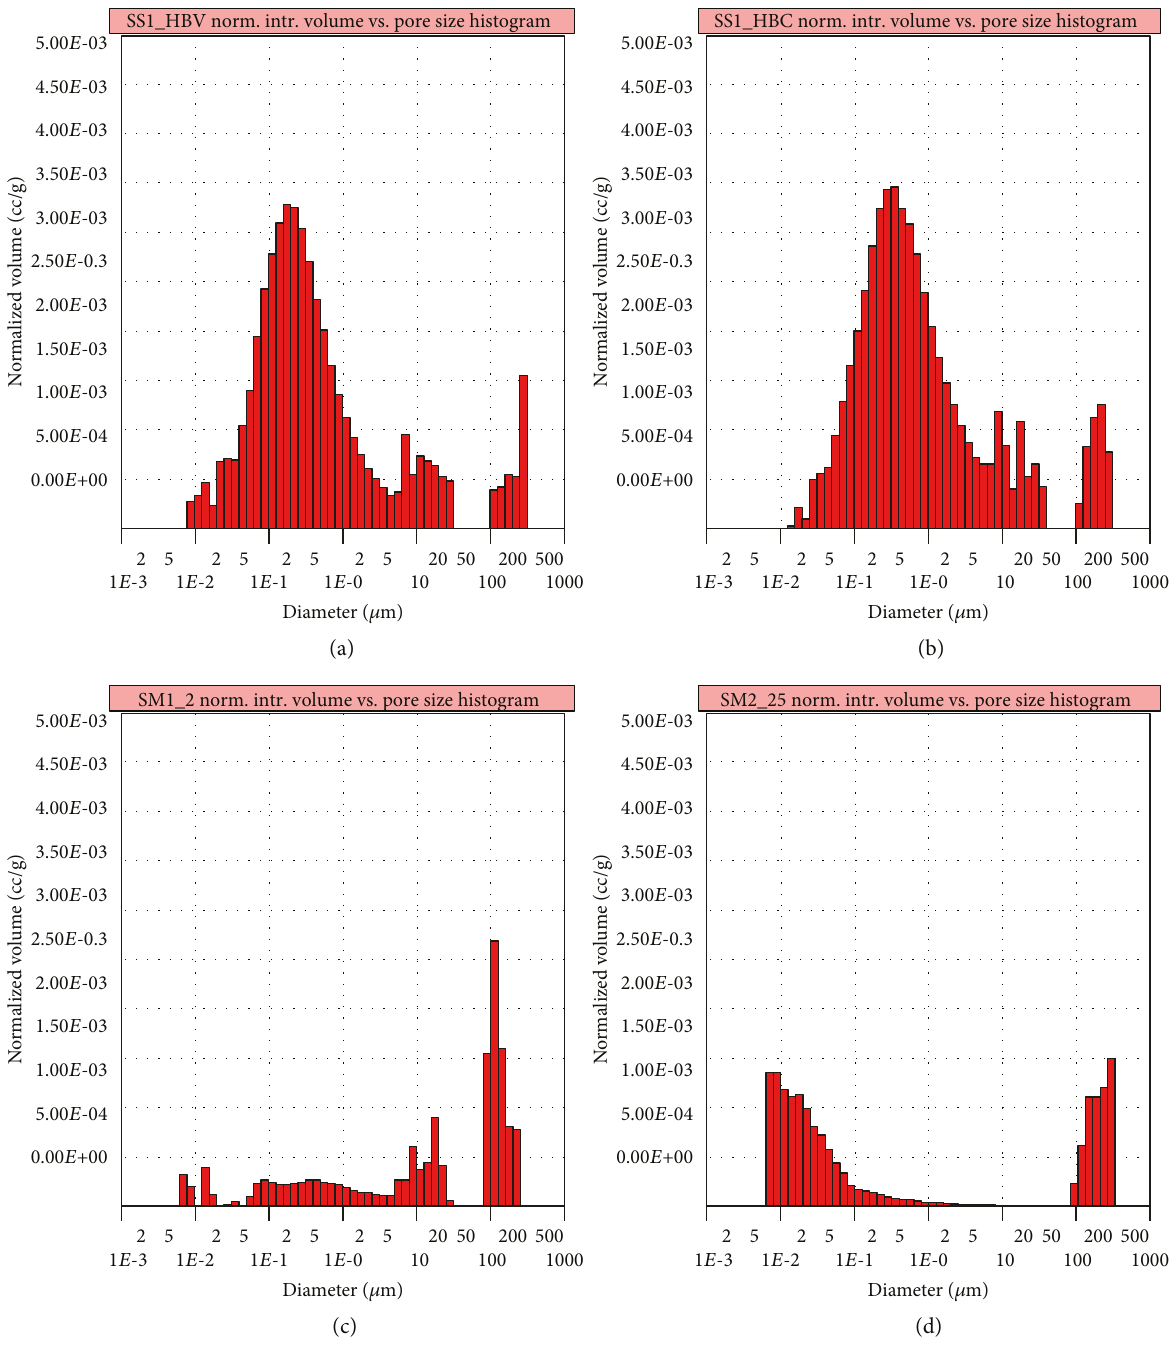
Figure 8: Results of Hg-intrusion pore size distribution analysis of fault